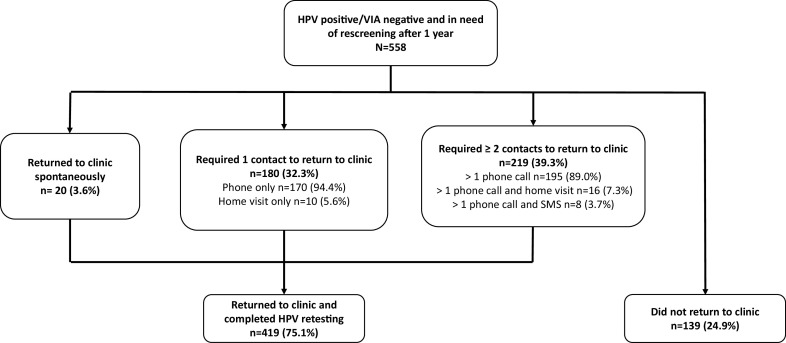
Overview of Recall Efforts to Encourage HPV-Positive VIA-Negative Women to Return for Clinic-Based HPV Testing ≥1 Year After Their First HPV-Positive Test ResultAbbreviations: HPV, human papillomavirus; VIA, visual inspection with acetic acid.